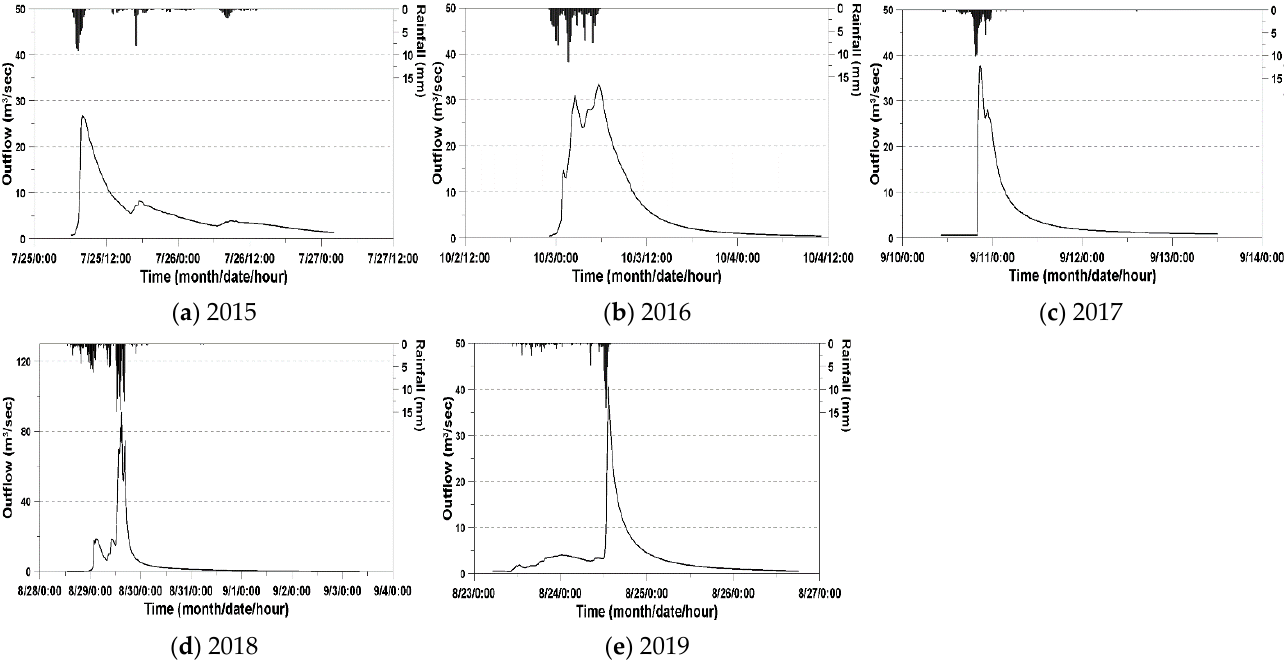
Figure 4. Annual maximum rainfall-runoff events, which occurred in 2015 ( a ); 2016 ( b ); 2017 ( c ); 2018 ( d ); and 2019 ( e ), analyzed in this